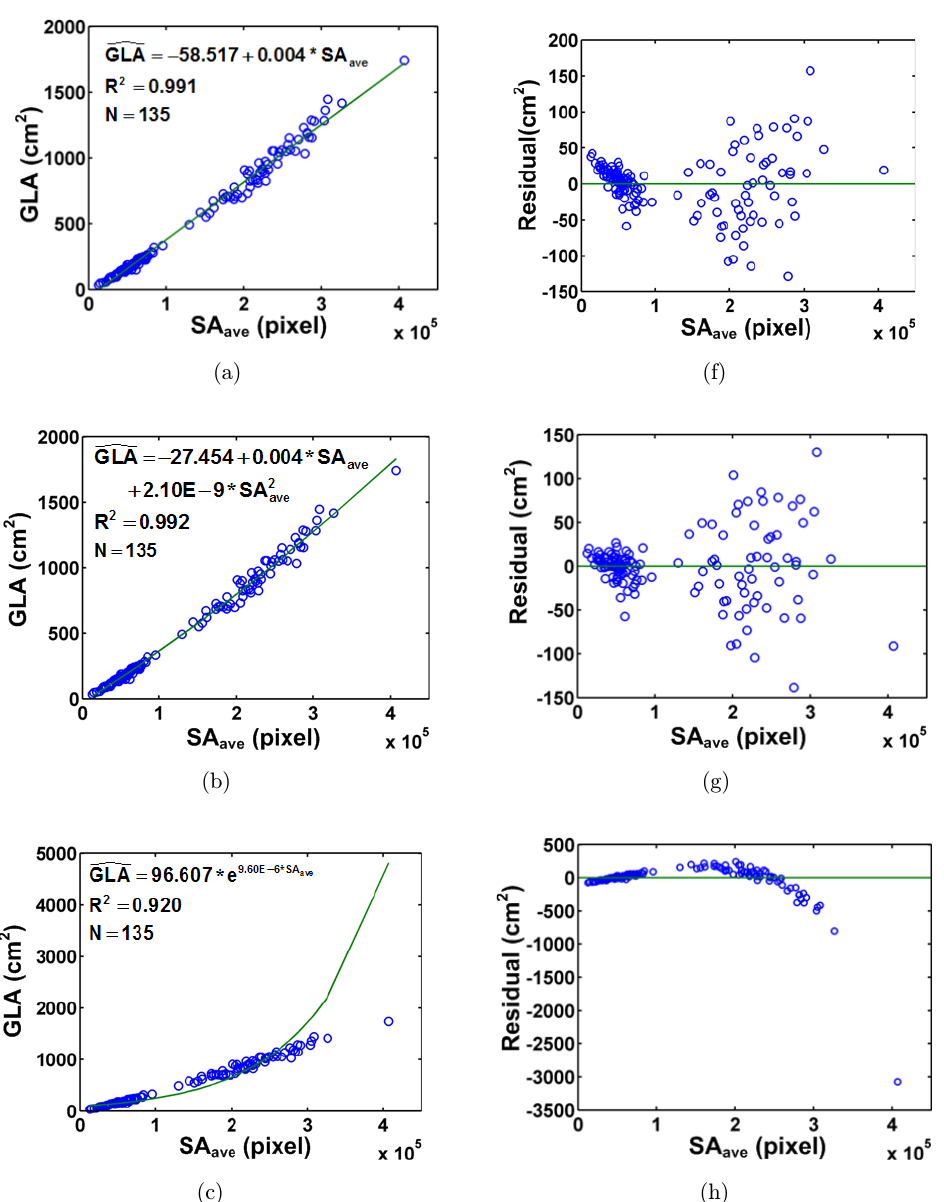
Fig. 4. Performance of the linear and nonlinear models. The relationships between the ELA and the average side-view projected area for modeling samples using the (a) linear model, (b) quadratic model, (c) exponential model, (d) power model and (e) IBLS model are shown in the left panel. The dispersion pattern of the residual for the respective (f) linear model, (g) quadratic model, (h) exponential model, (i) power model and (j) IBLS model are shown in the right panel.